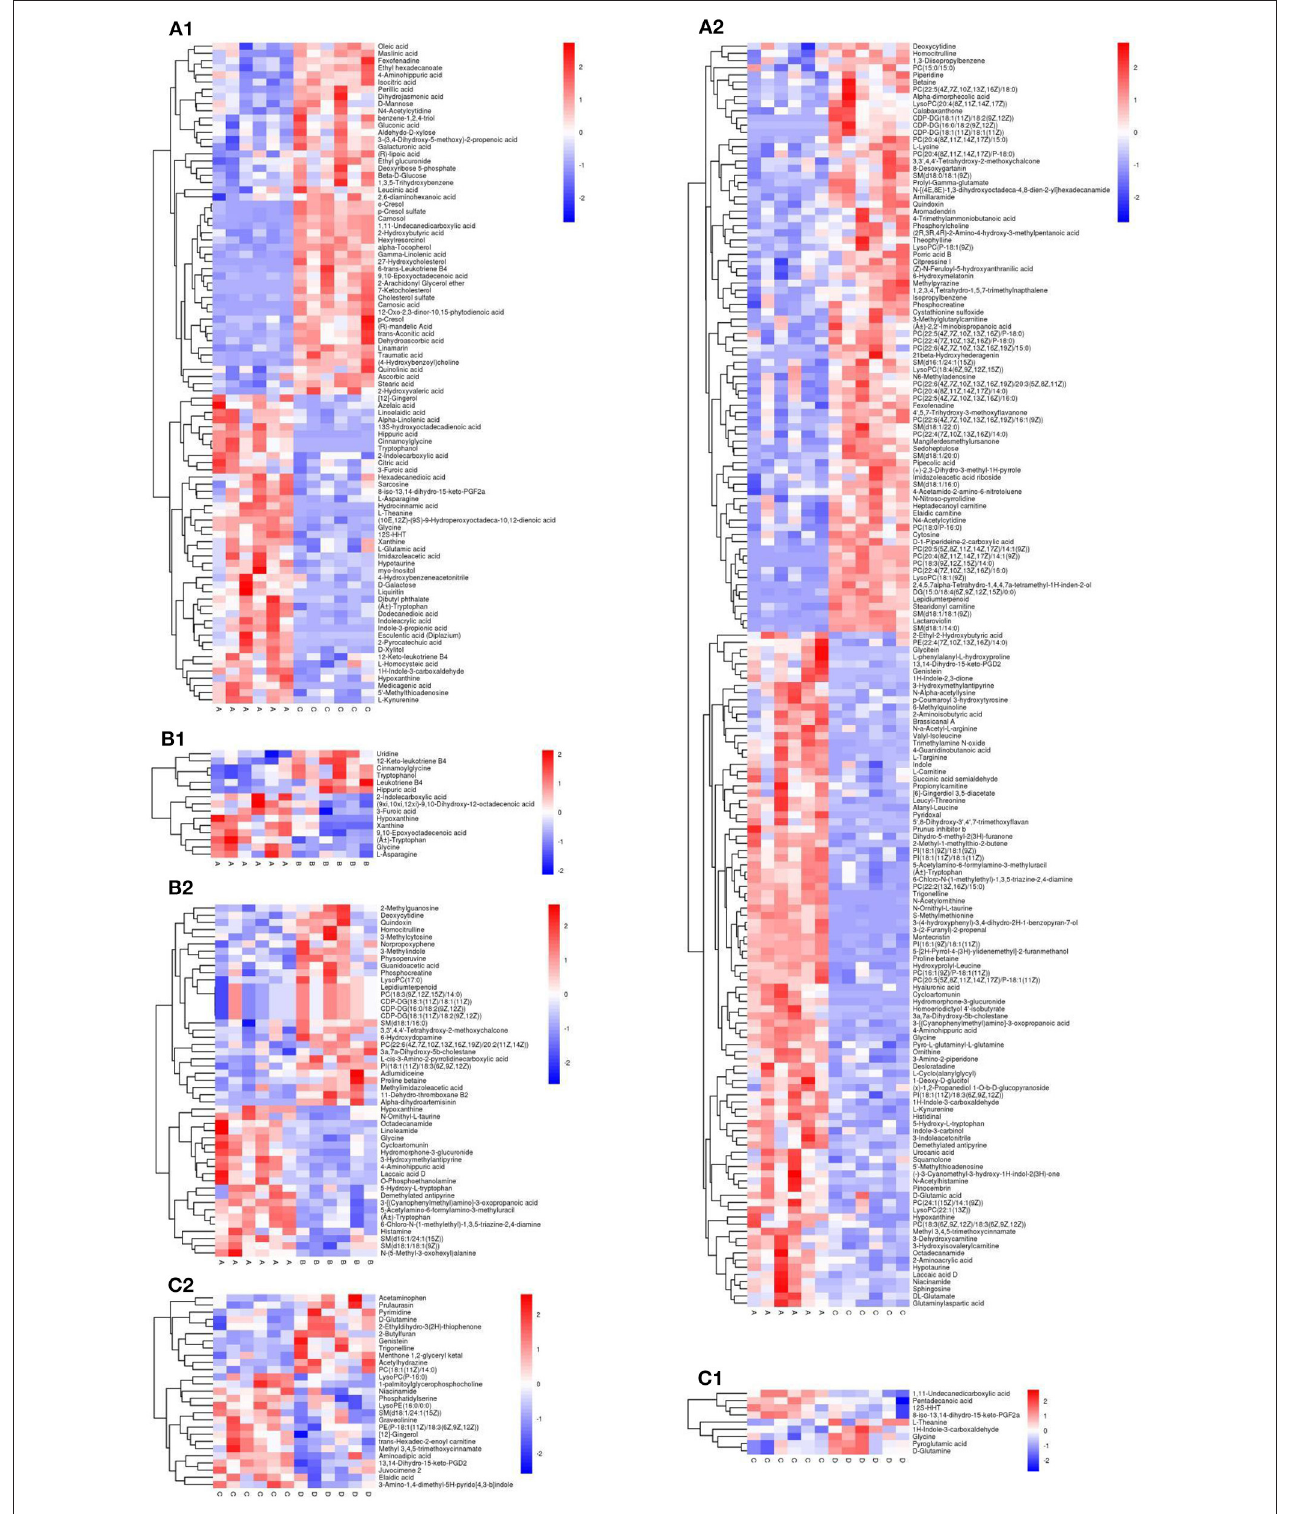
FIGURE 9 | Heat map for the group NCD vs. HFD [ (A 1 ) NEG ion, (A 2 ) POS ion], NCD vs. NCD + MBPs [ (B 1 ) NEG ion, (B 2 ) POS ion], HFD vs. HFD + MBPs [ (C 1 ) NEG ion, (C 2 ) POS ion]. Metabolites that were significantly up-regulated were red, metabolites that were significantly down-regulated were blue, and metabolites that were not significantly different were gray.